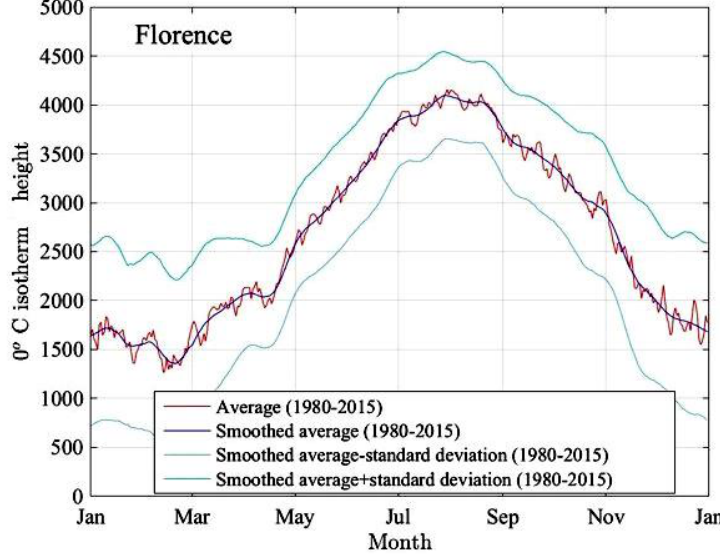
Figure 7. Daily height of the 0 °C isotherm over the city of Florence, Italy, obtained by averaging 35-year observation data from the modern-era retrospective analysis for research and applications (MERRA) database [48].